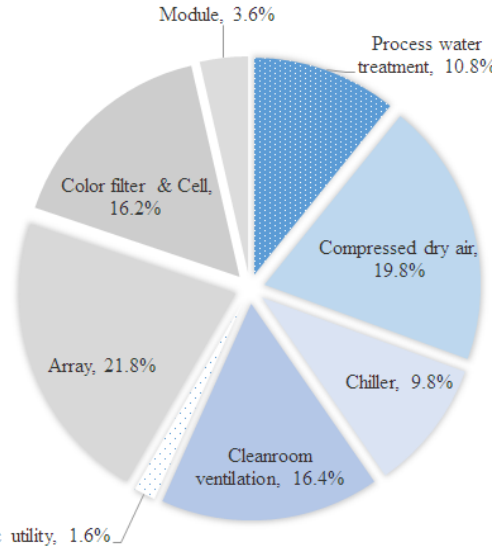
Figure 2. Distribution of electricity utilization in 2010.